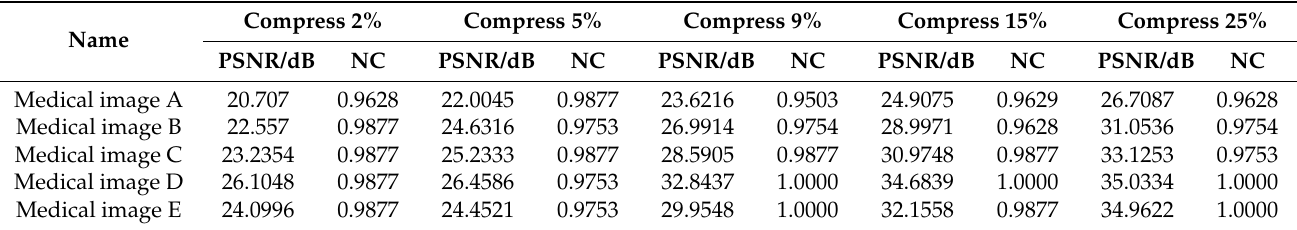
Table 2. The result under JPEG compression attacks.